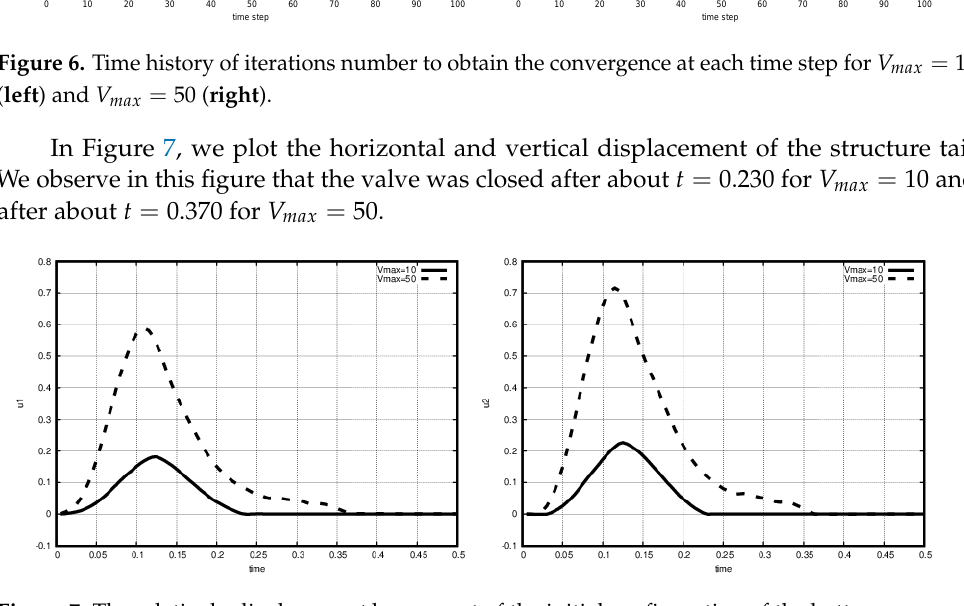
Figure 7. The relatively displacement by rapport of the initial configuration of the bottom corner of the tail segment of the structure: horizontal ( left ) and vertical ( right